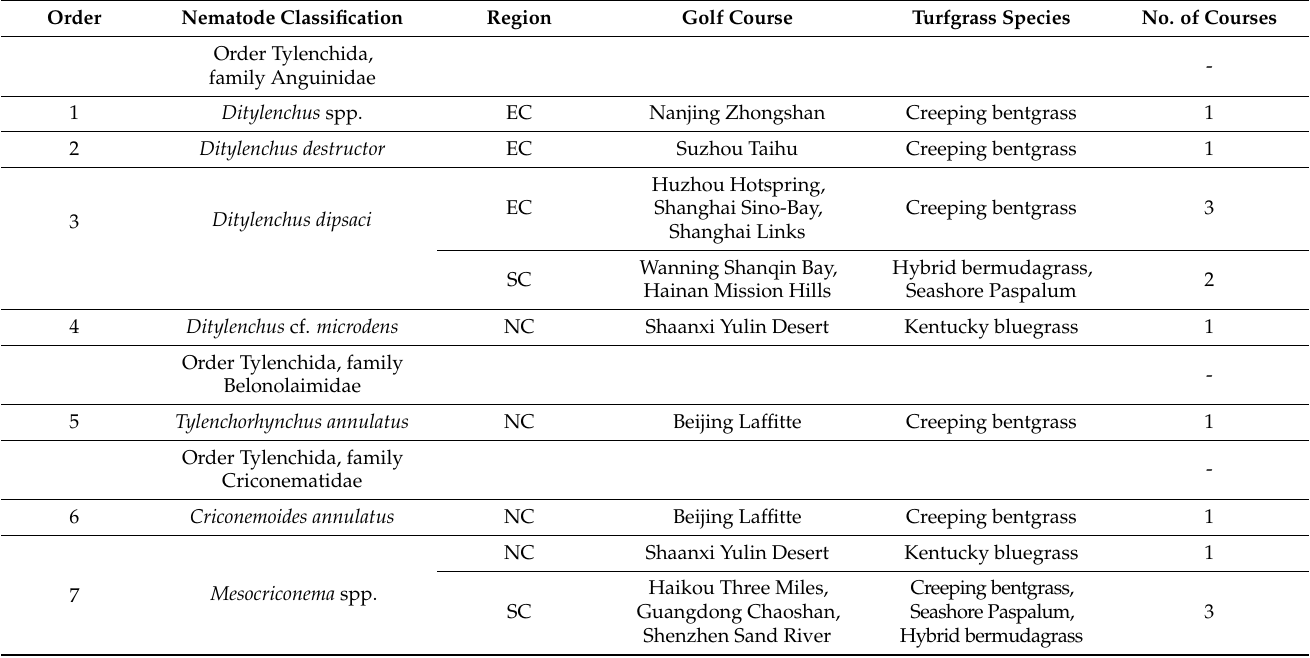
Table 2. The classification and distribution of plant-parasitic nematodes in North, South, and East